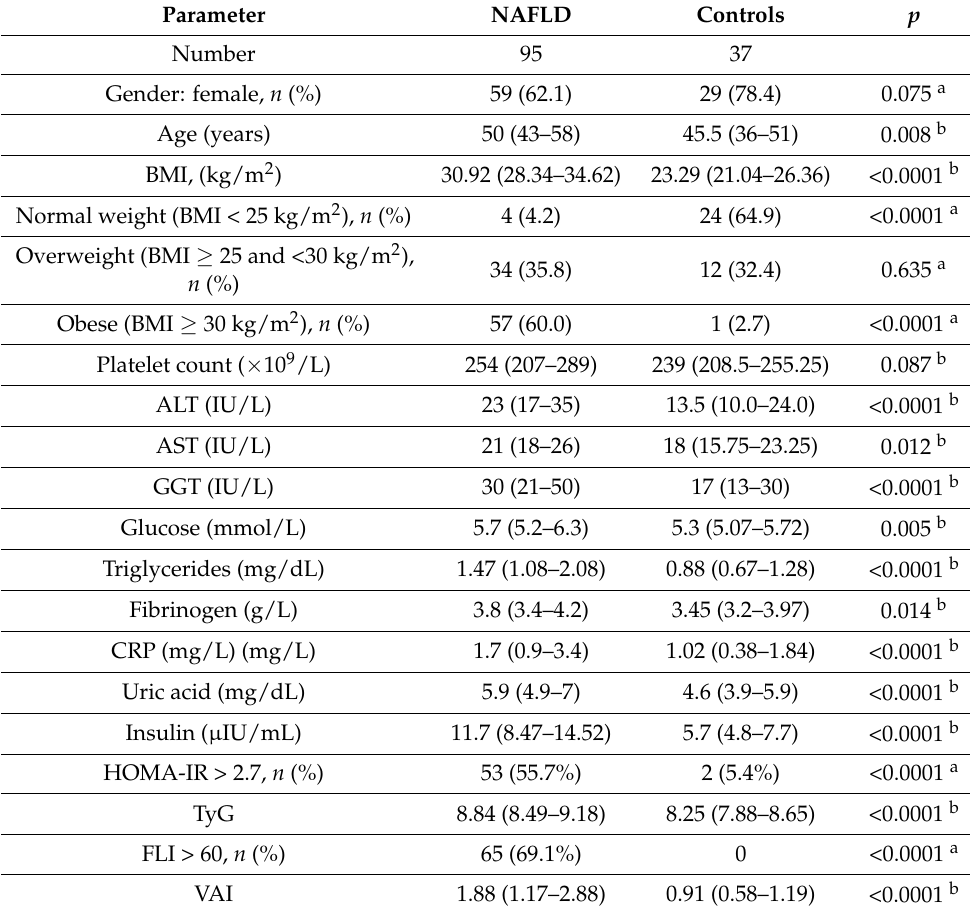
Table 1. Anthropometric and biochemical parameters of patients with NAFLD and controls. Parameter